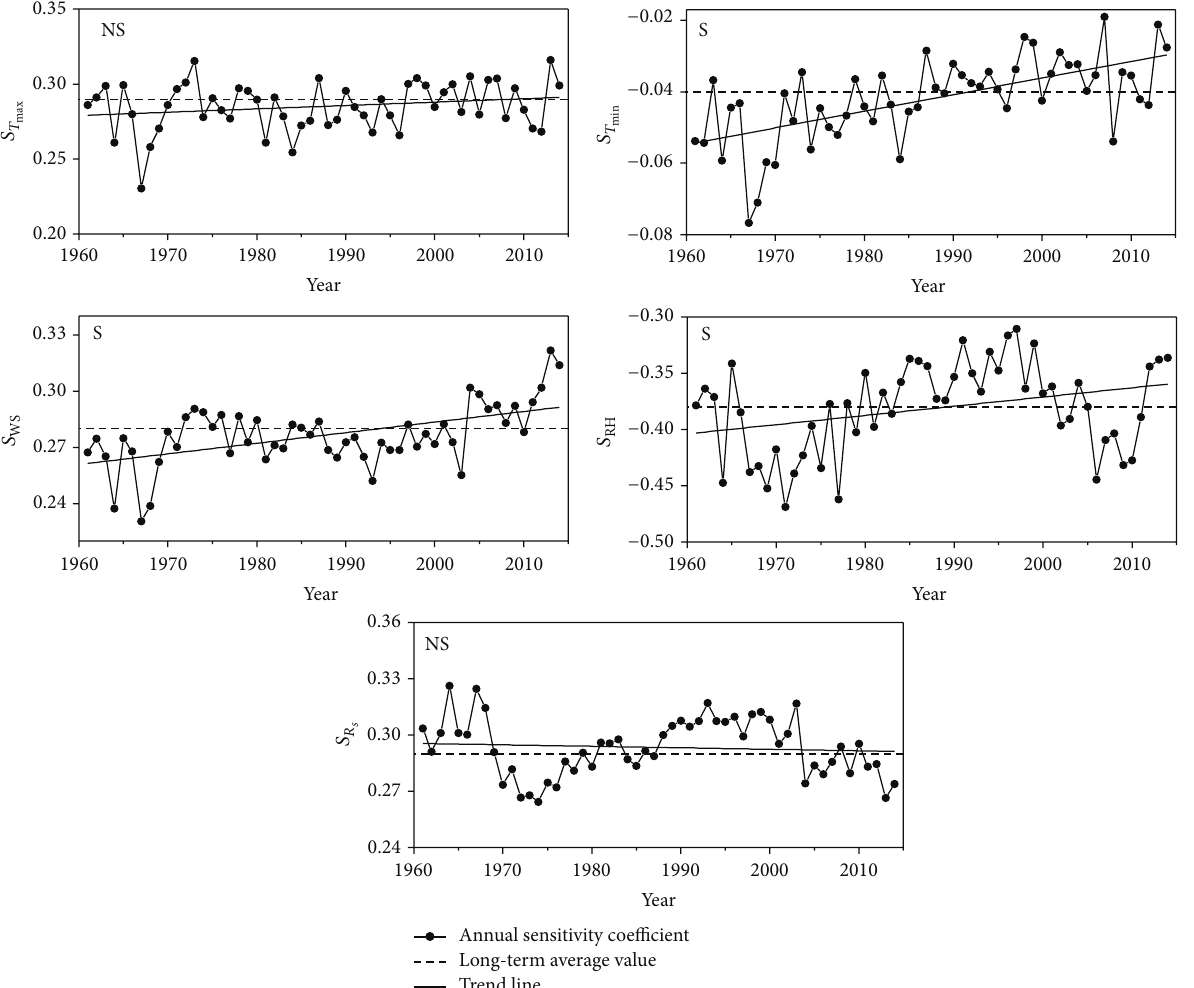
Figure 10: Interannual variations of sensitivity of ET 0 in relation to 𝑇 max , 𝑇 min , WS, RH, and 𝑅 𝑠 .